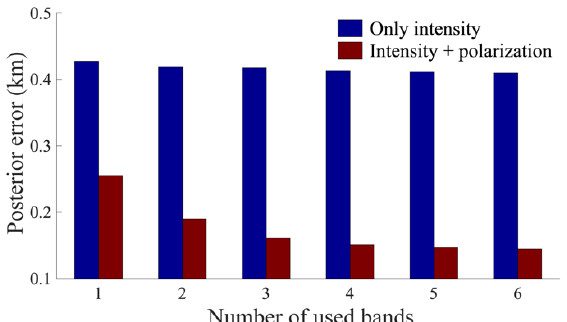
Figure 8. The posterior errors of ALH along the number of used bands for “only intensity” and “intensity + polarization” multi- viewing measurements with 75% priori errors of